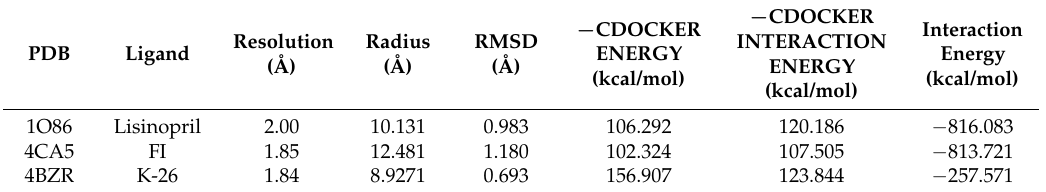
Table 3. The information of ACE crystal structures and docking analysis of initial